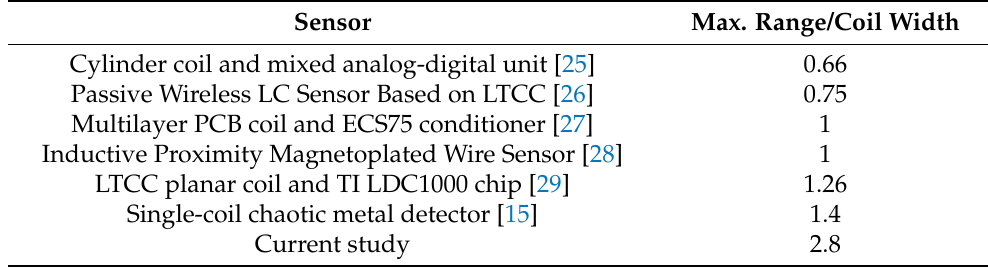
Table 3. Comparing the proximity range of the developed sensor with the sensors in referred